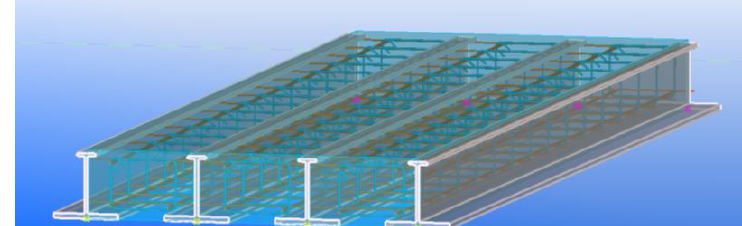
Fig. 1 . Structure with concrete encased steel beams with I